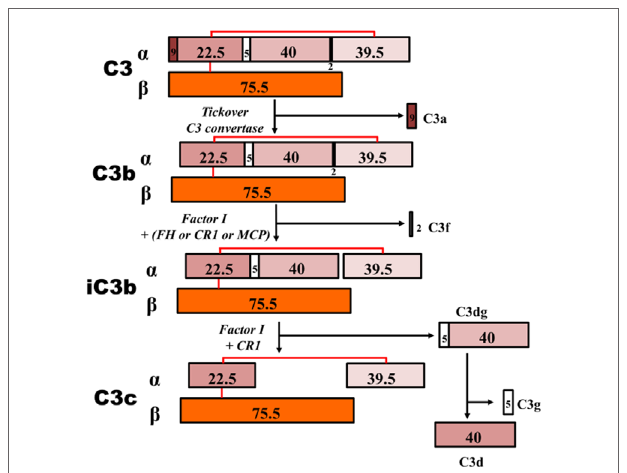
FiGURe 6 | C3 proteolytic cascade . The hydrolysis of C3 leads to release of activation products C3a – an anaphylatoxin – and C3b. C3b binds activating surfaces, such as a bacterial cell wall, triggering the alternative pathway cascade. This activation is controlled by regulator molecules, such as FI, FH, and complement receptor 1 (CR1), that degrade C3b into products that cannot contribute to the formation of the C5 convertase (iC3b, C3c, C3dg, and C3d). Detection of these inactive breakdown products is considered evidence of activation of C3. The numbers, in kilodaltons, represent the molecular masses of the corresponding polypeptides. MCP, membrane cofactor